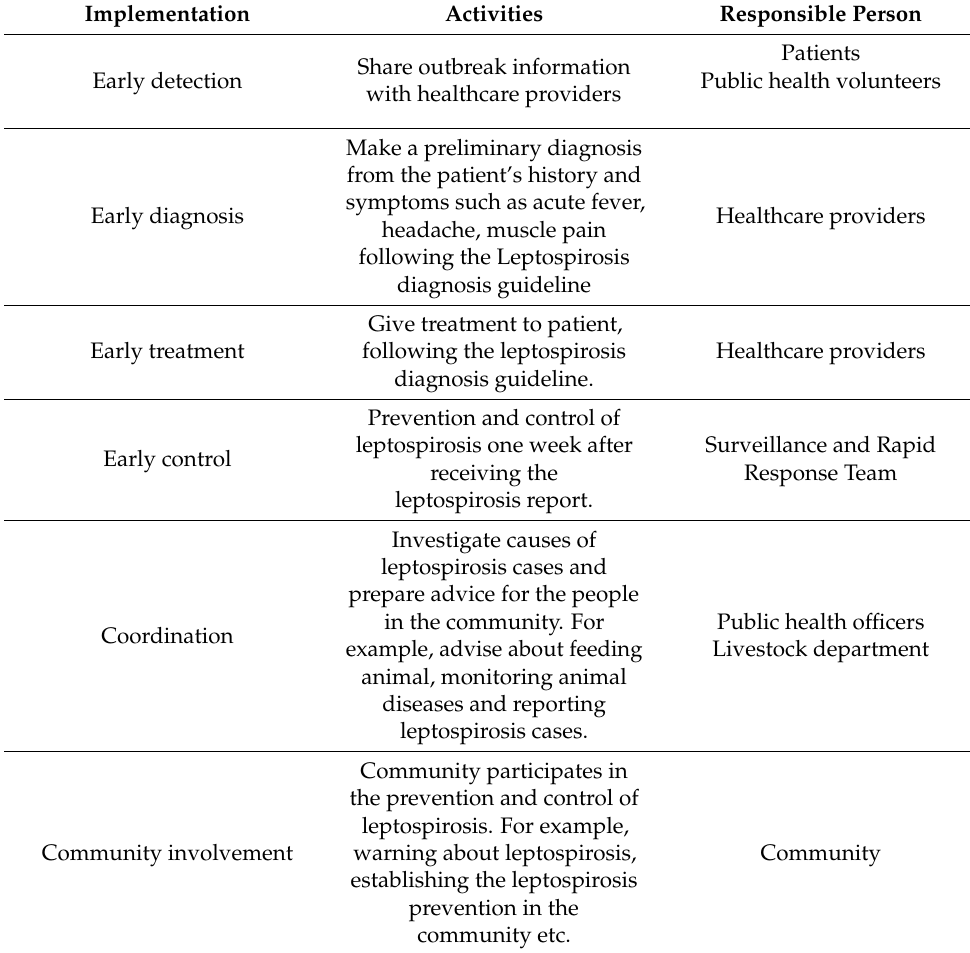
Table 2. Implementation of the 4E2C tool of the Ministry of Public